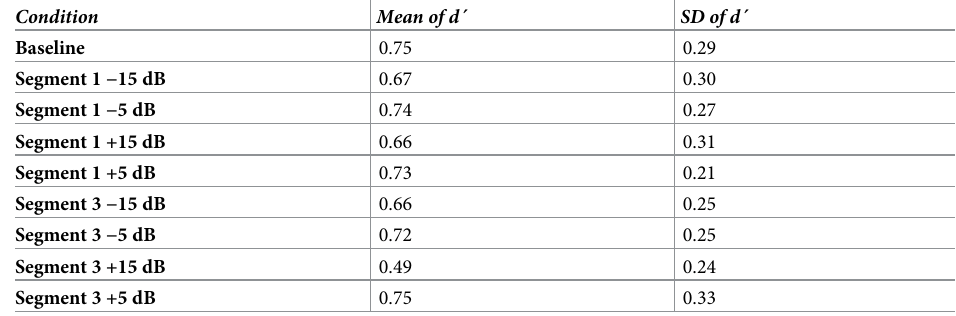
Table 1. Mean sensitivity ( d´ ) across listeners in the four different conditions of Experiment 1. N =